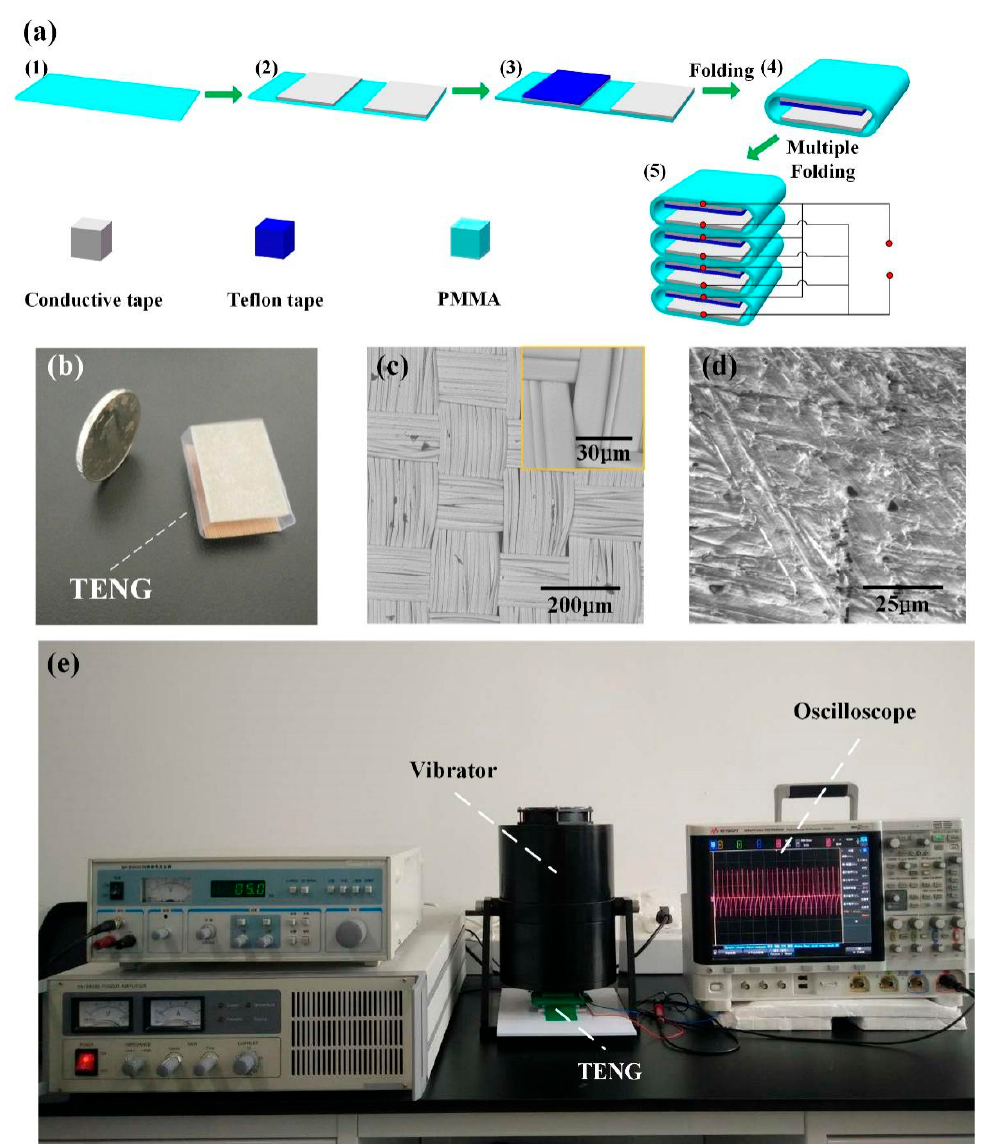
Figure 1. ( a ) Preparation process of the copper–nickel-based triboelectric nanogenerator (CN-TENG). ( b ) Photograph of the fabricated CN-TENG unit. SEM image showing the surface of the ( c ) conductive tape and ( d ) polytetrafluoroethylene (PTFE) tape. ( e ) The mechanical vibration system and measurement system.